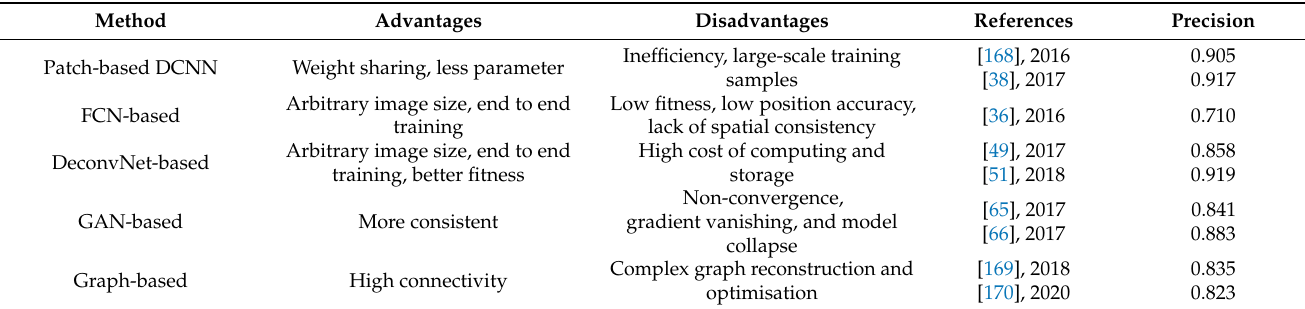
Table 4. Comparison of different data-driven methods on Massachusetts road